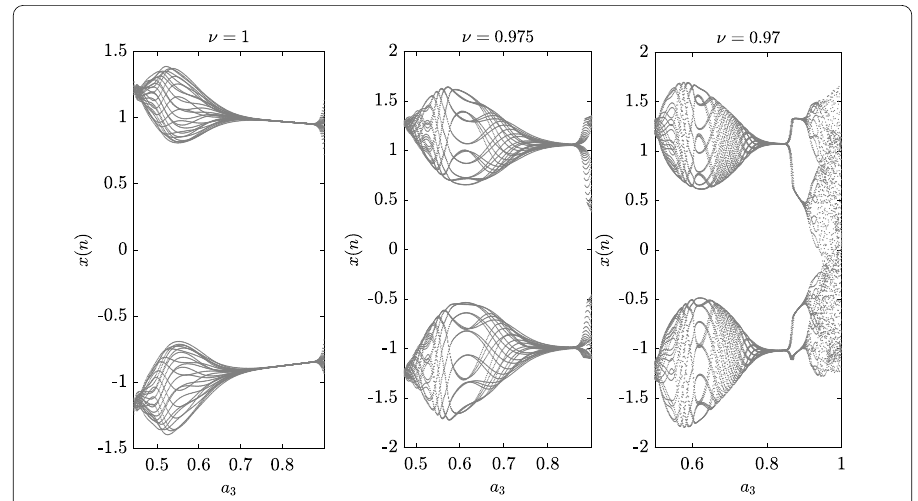
Figure 18 Bifurcation diagrams of the fractional-order Wang map for different fractional orders